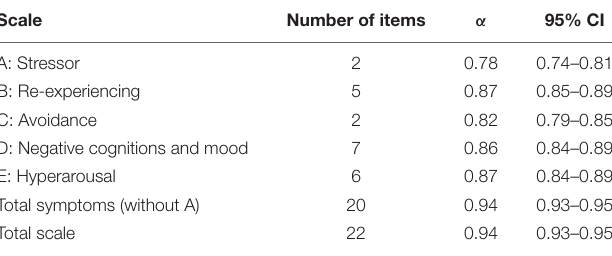
TABLE 6 | Cronbach’s alpha for total scale and